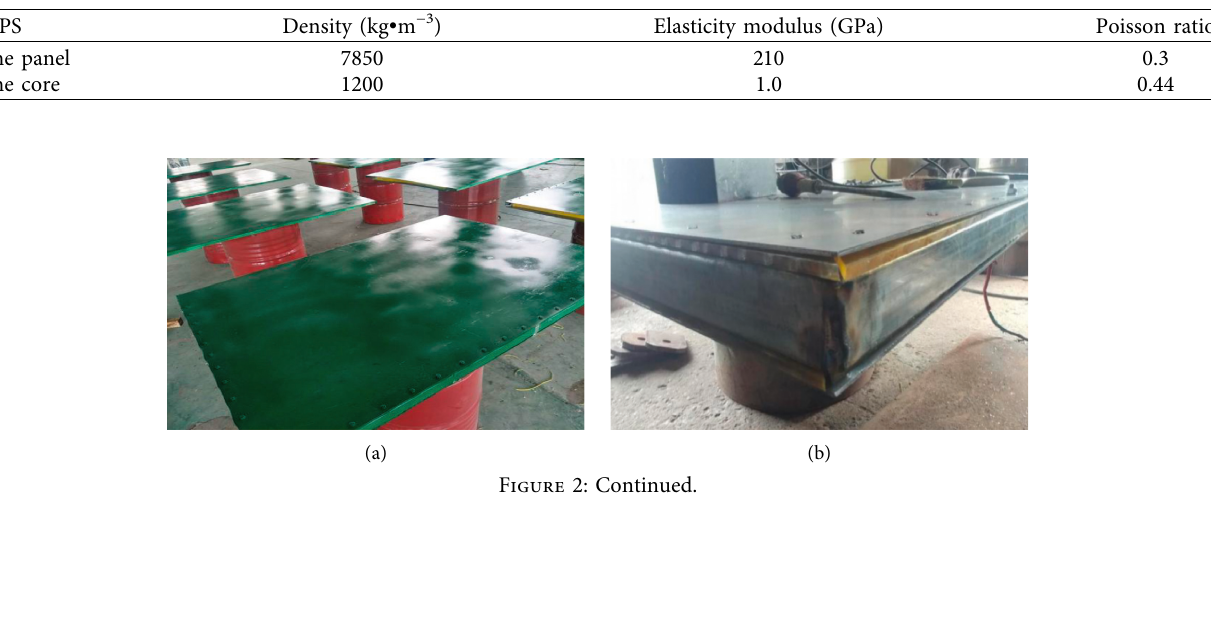
Figure 1: The layout diagram of SPSs: (a) the structural type of SPS; and (b) the geometric parameters. Table 1: Material parameters of SPS.